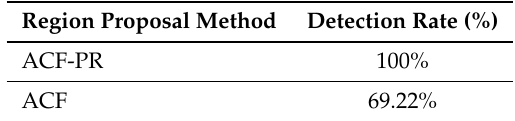
Table 2. The cyclist detection rate with different region proposal